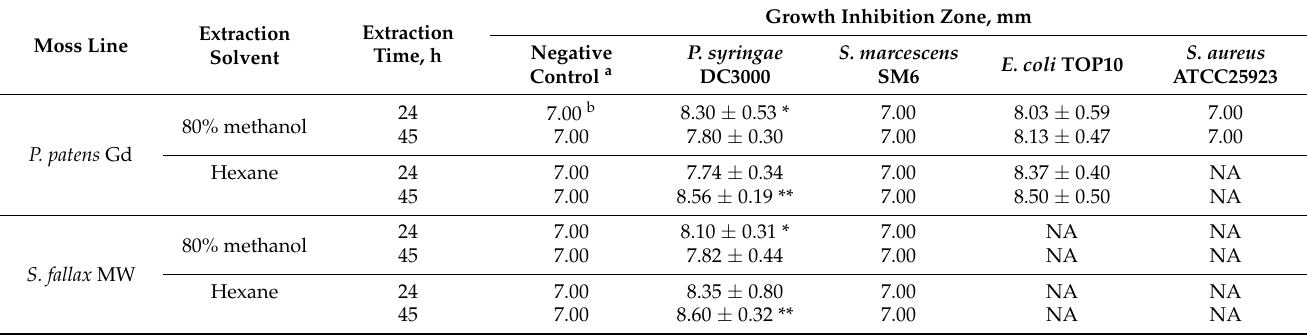
Table 2. Bacterial growth inhibition activity of moss extracts in DDM test.